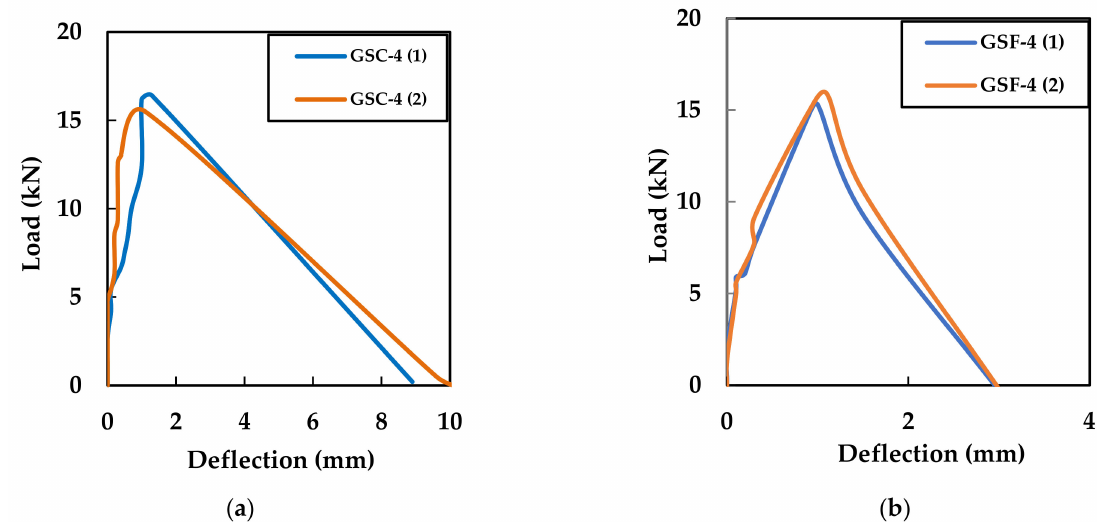
Figure 10. Load–deflection behaviour of ( a ) GSC-4 and ( b ) GSF-4.